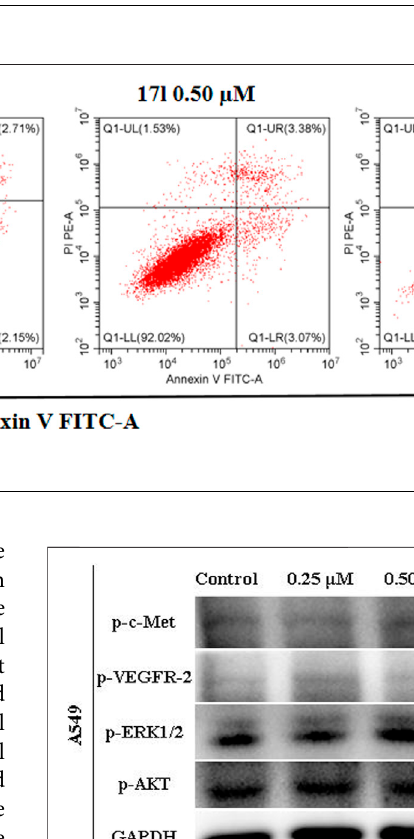
FIGURE 4 | Cell cycle progression analyses of human lung adenocarcinoma (A549) cells cultured with compound 17l for 72 h.